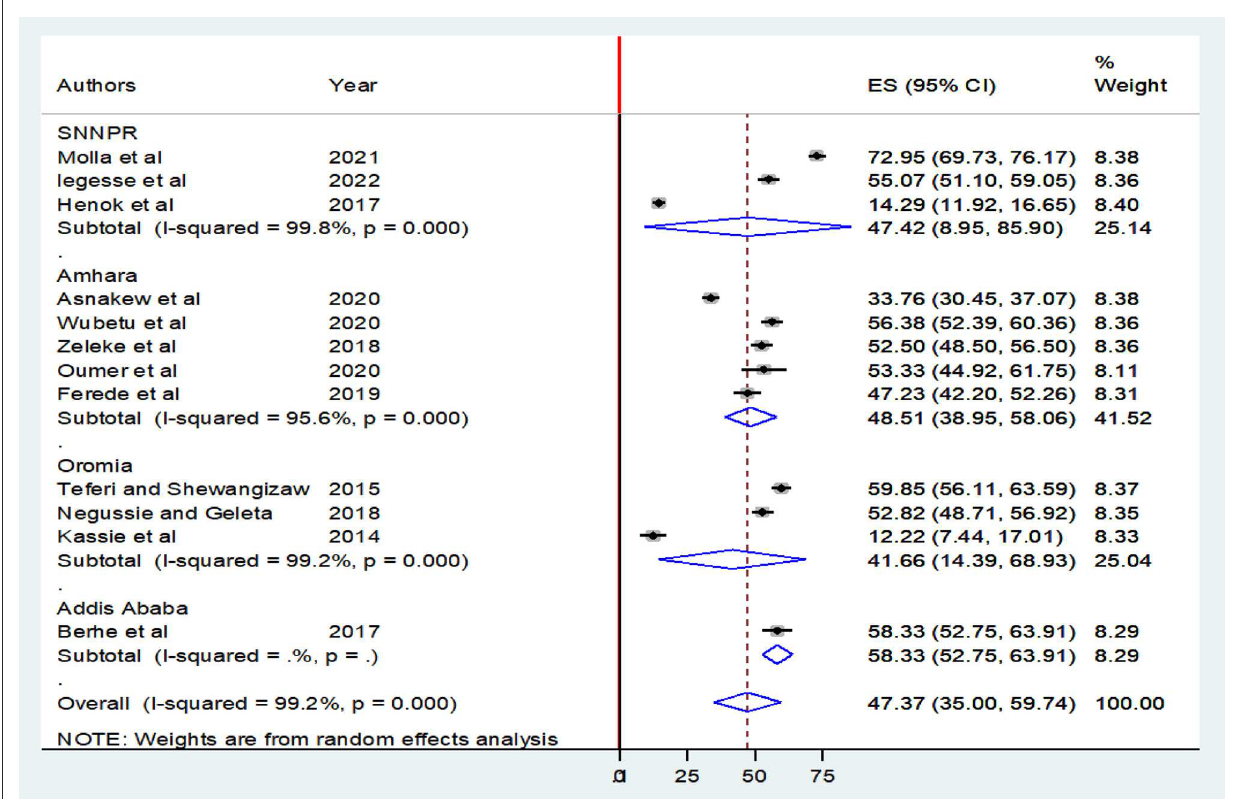
FIGURE5 Forest plot showing subgroup meta-analysis by region for the overall prevalence of good epilepsy knowledge among Ethiopians.